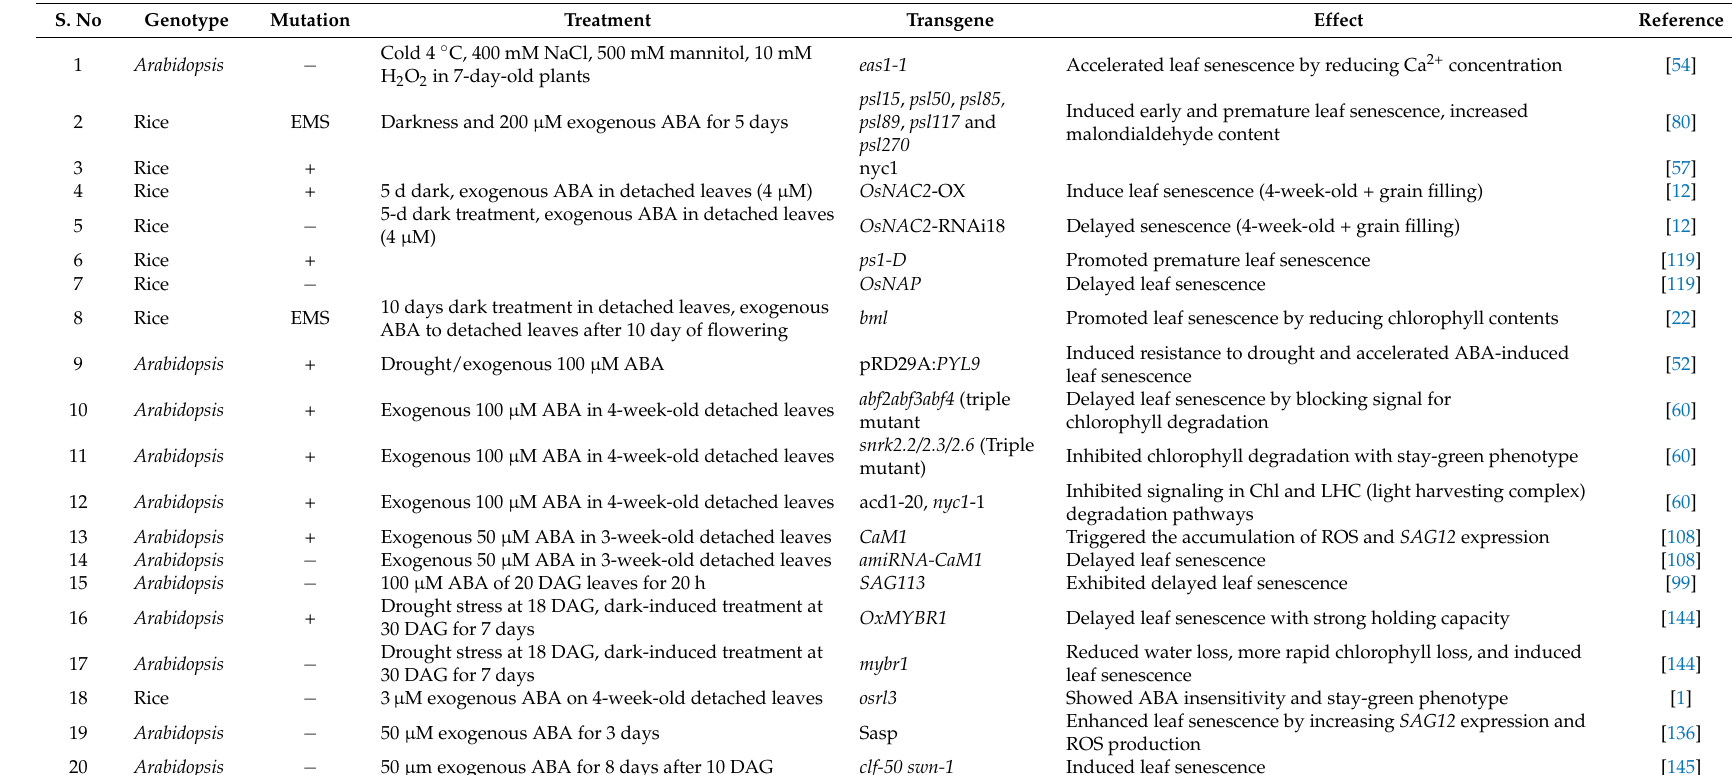
Table 1. Mutations that alter the effects of ABA-induced leaf